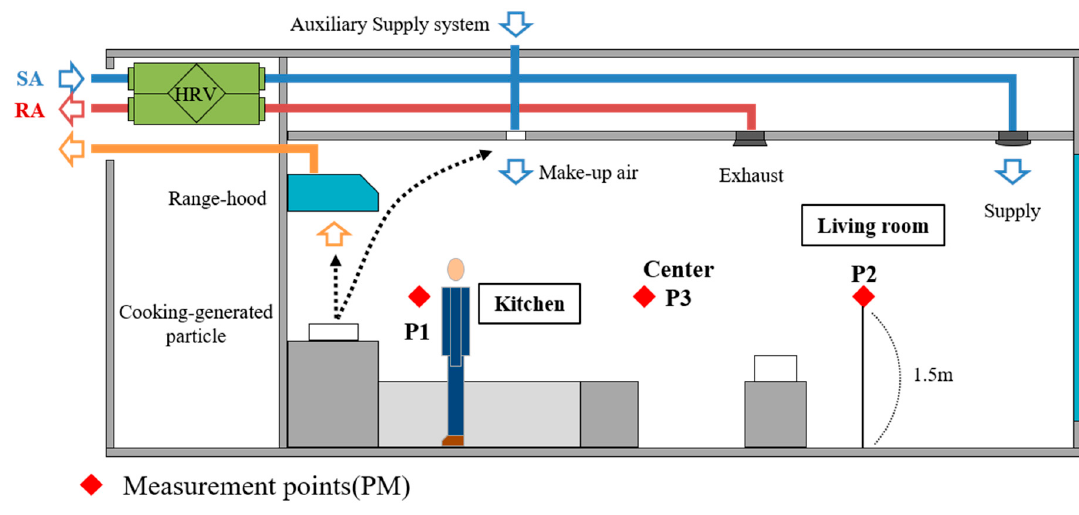
Figure 2. Section diagram of kitchen and living room.